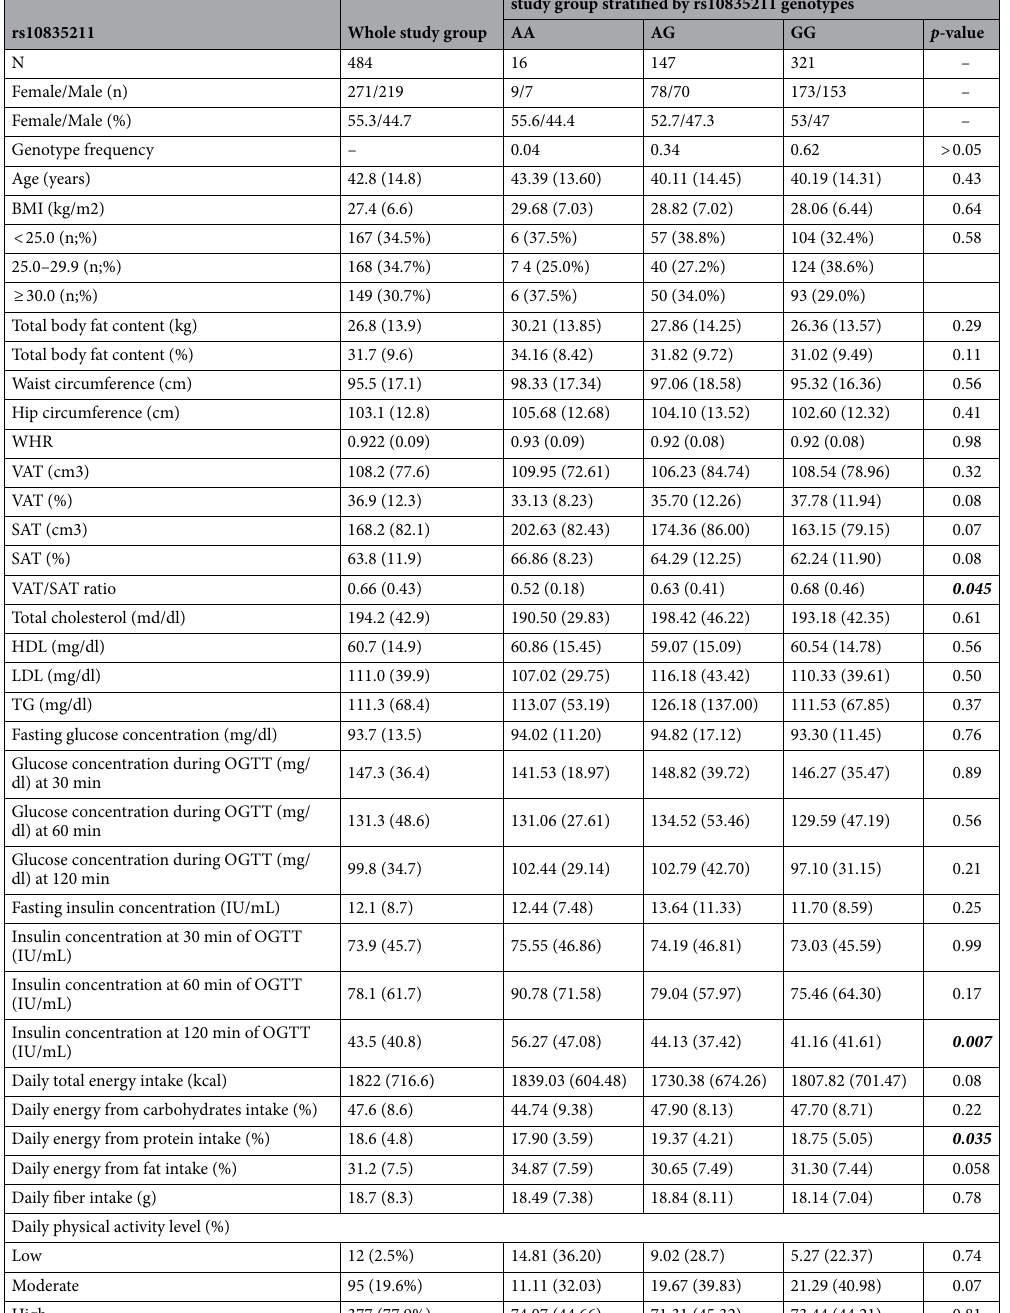
Table 2. The study group characteristics stratified by rs10835211 genotypes. Data are presented as the arithmetic mean values and standard deviations (SDs), or numbers and percentage if indicated. Standard deviations are in